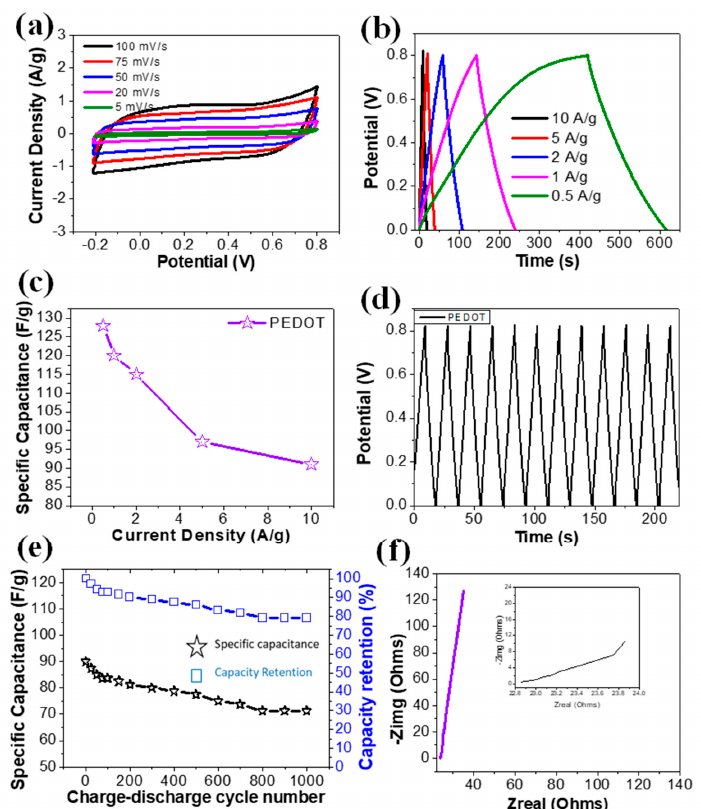
Figure 7. Electrochemical measurements of PEDOT on PLA4Gr6 electrode in 0.2 M KCl solution: ( a ) Cyclic voltammograms at different scan rates, ( b ) Galvanostatic charge-discharge plots at different current densities, ( c ) Specific capacitance v/s current density plots, ( d ) Starting 10 cycles of charge- discharge, ( e ) Cycle test (till 1000 cycles) and ( f ) Electrochemical impedance